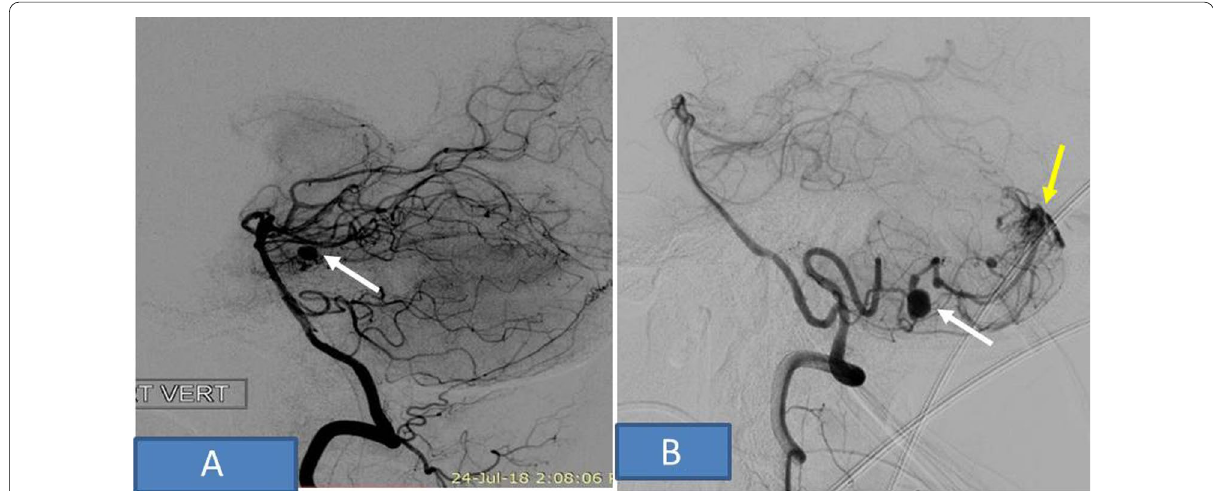
Fig. 6 Associated Aneurysms in AVM; a DSA image showing intranidal aneurysm (white arrow), b DSA image showing feeder vessel aneurysm in PICA (white arrow) supplying the AVM in the posterior fossa (yellow arrow)